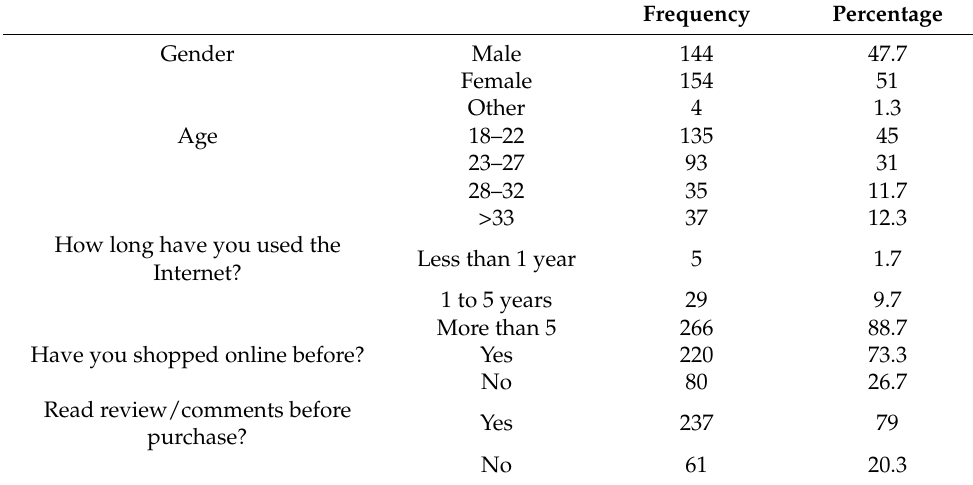
Table 3. Respondents’ demographic profile ( n =